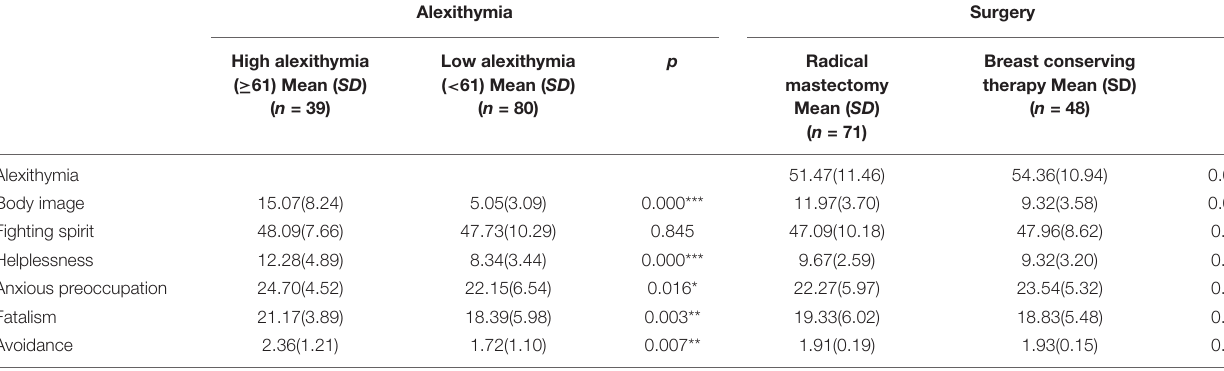
TABLE 1 | Differences between alexithymia and surgery groups on dependent variables.